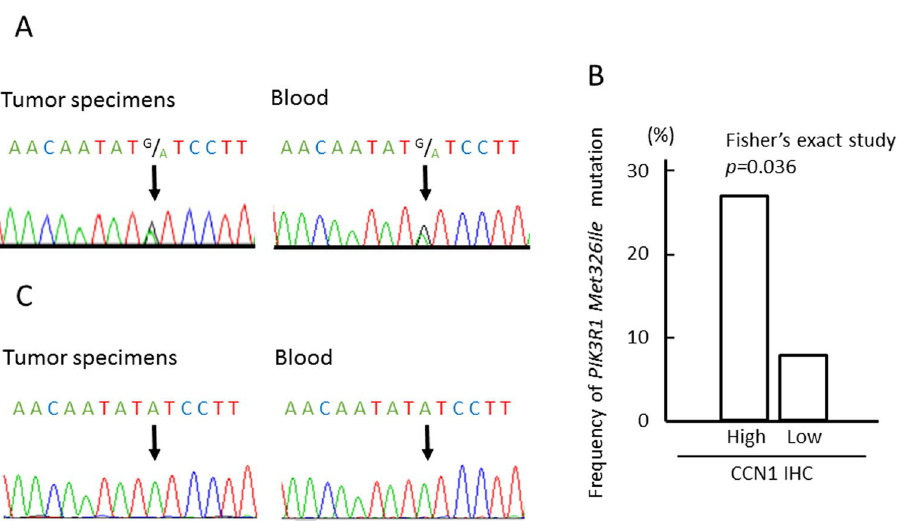
Figure 3. PIK3R1Met326Ile mutations in glioblastoma patients. ( A ) Electropherogram of patients with heterozygous mutation of PIK3R1Met326Ile . ( B ) The frequency of PIK3R1Met326Ile mutations was significantly higher in the CCN1 high expression group compared with the CCN1 low expression group. Statistical significance was calculated by Fisher’s exact test. ( C ) Electropherogram of patients with homozygous mutation of PIK3R1Met326Ile